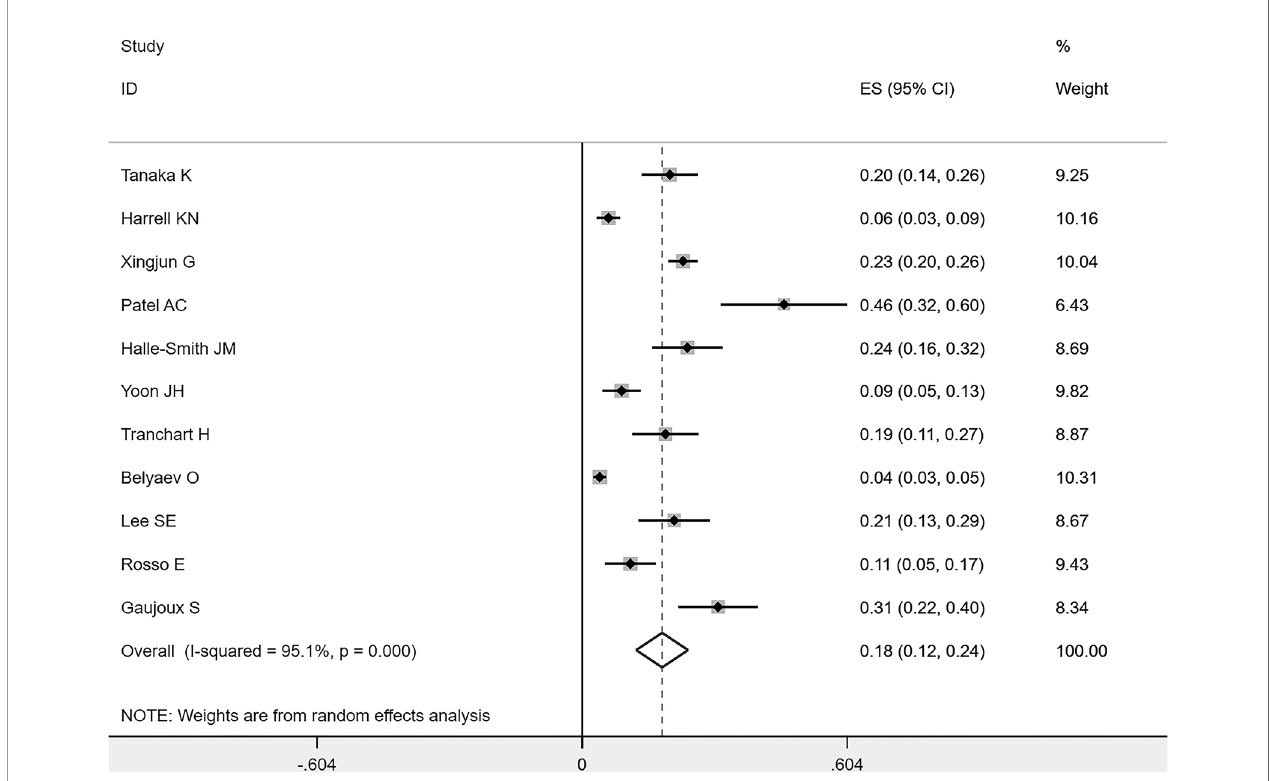
FIGURE 2 | Forest plots of POPF ’ s prevalence